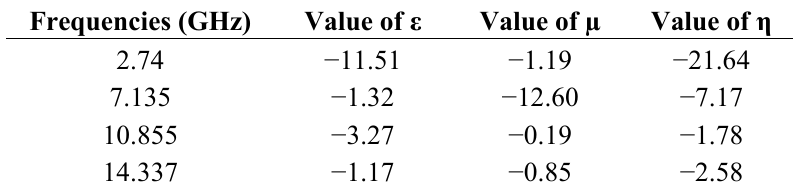
Table 4. Real values of ε, µ and η in the desired resonance frequency bands for the 1 × 1 unit